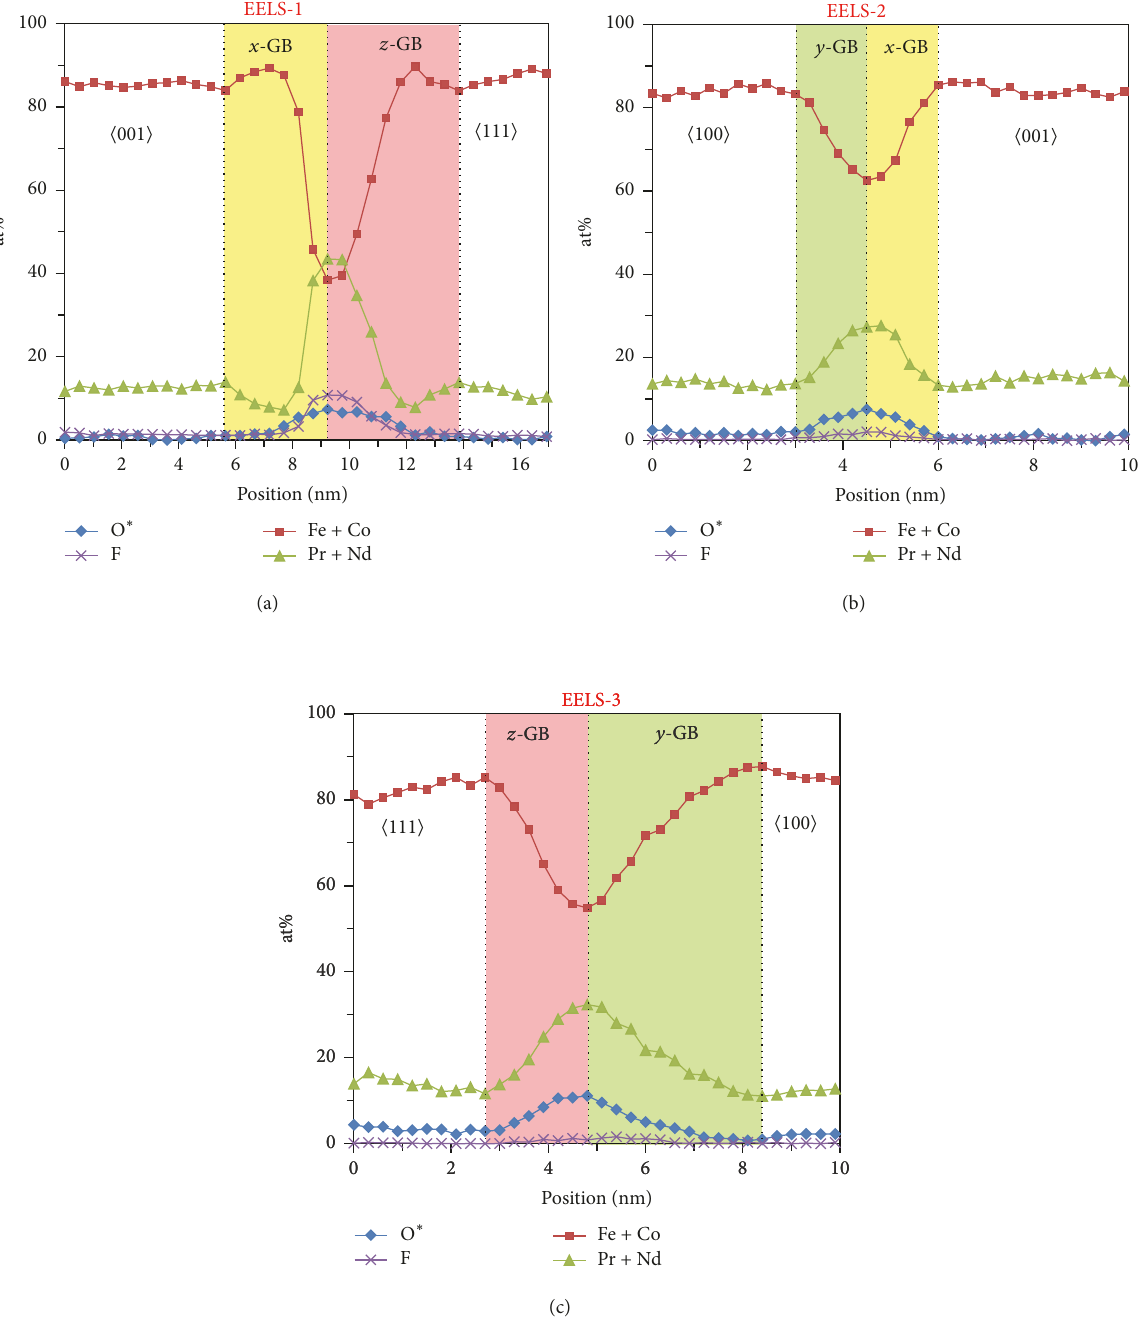
Figure 7: EELS line scans across GBs showing the asymmetric change of composition depending on the relative orientation of the GBs with respect to the neighbouring hard magnetic grains. (a) EELS-1 transition between ⟨001⟩ and ⟨111⟩ orientation ( 𝑥 - 𝑧 -GB). (b) EELS-2 line scan across the asymmetric 𝑦 - 𝑥 -GB (from ⟨100⟩ to ⟨001⟩ ) and (c) EELS-3 line scan across 𝑧 - 𝑦 -GB (from ⟨111⟩ to ⟨100⟩ ). The change in the chemical composition from the 2-14-1 grain into the GB is steeper in the 𝑥 -GB compared to 𝑧 -GB in (a); in the 𝑥 -GB compared to the 𝑦 -GB in (b); and in the 𝑧 -GB compared with the 𝑦 -GB in